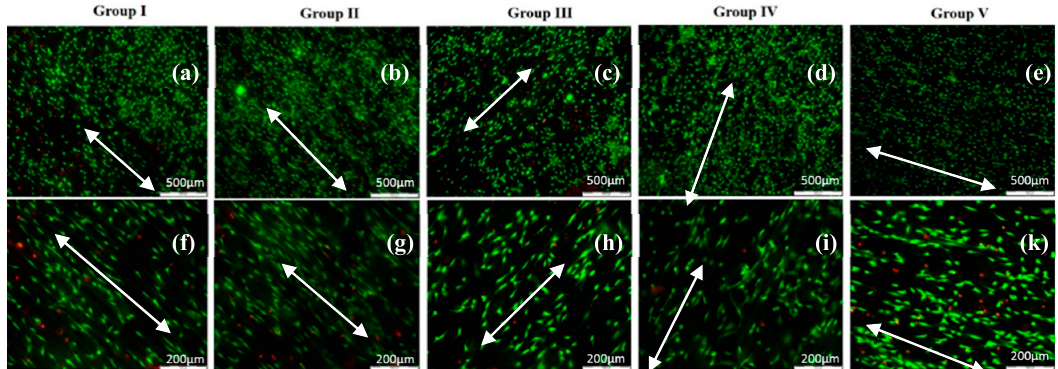
Figure 13. Fluorescence images of live-dead staining of mouse calvaria osteoblasts (MC3T3) cell alignment after 1-day culture on diverse blends of fs laser modified Ch/HAp/ZrO 2 topographies ( a – e ). Close up images of the small protrusions of MC3T3 cells aligned to the laser created grooves on Ch/HAp/ZrO 2 ( f – k ); white arrows show the direction of surface patterning and thus the direction of the grooves, which coincided with that of the cells.